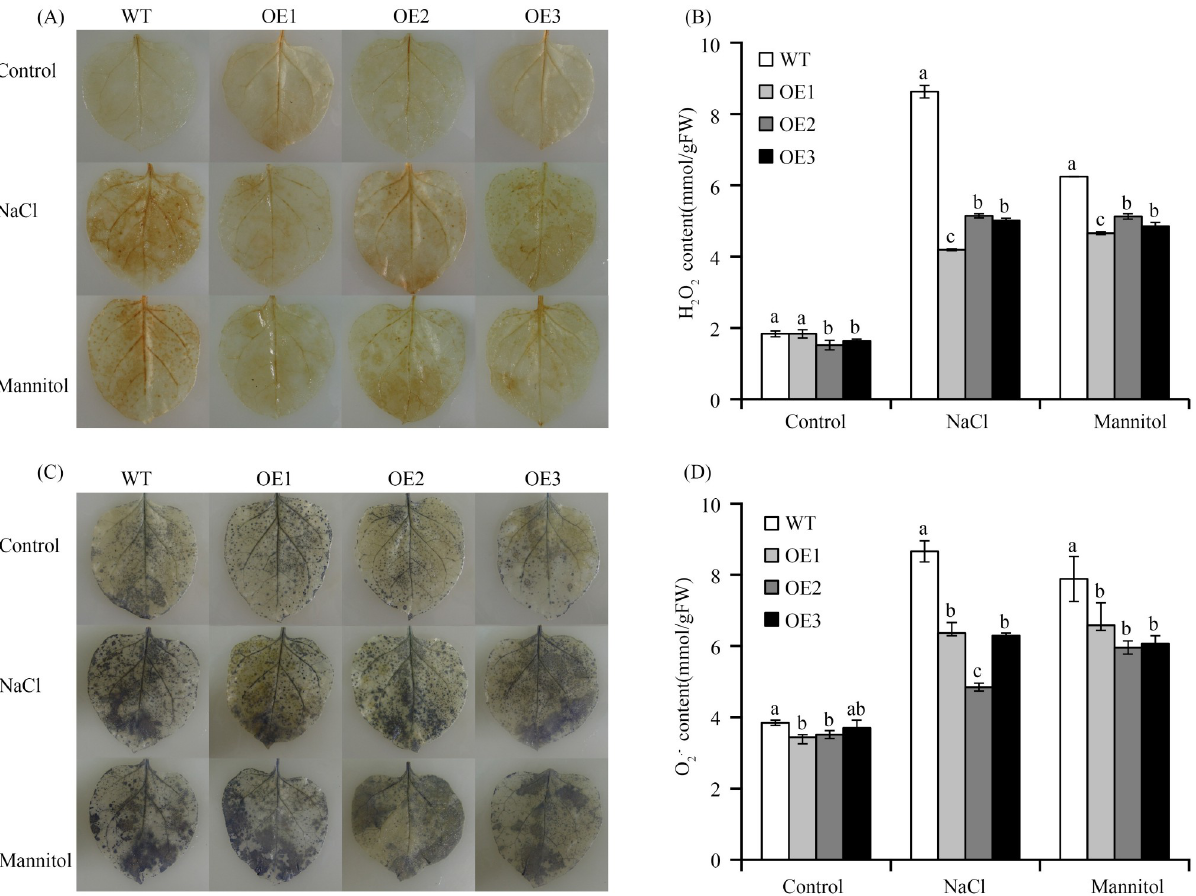
Fig 8. ROS levels of transgenic plants under high salt and osmotic stress conditions. (A) DAB staining for detection of H 2 O 2 in WT and transgenic plant leaves after salt and mannitol treatment, (B) The content of H 2 O 2 in WT and transgenic lines after salt and mannitol treatment, (C) NBT staining for detection of O 2 � - in WT and transgenic plant leaves after salt and mannitol treatment, (D) The content of O 2 � - in WT and transgenic lines after salt and mannitol